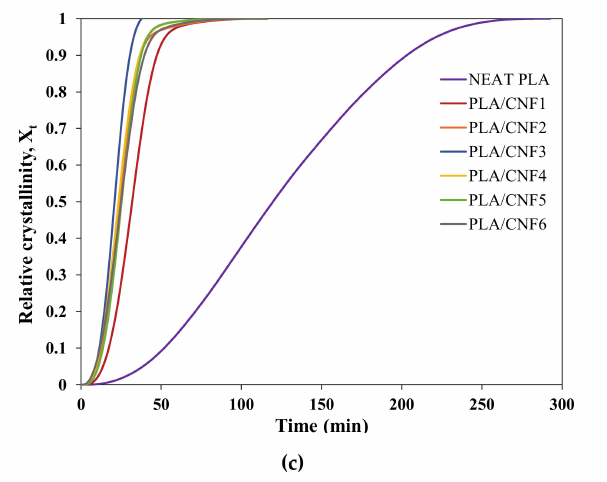
Figure 3. The relative crystallinity of neat PLA and PLA/CNF nanocomposites at ( a ) 90, ( b ) 100, and ( c ) 110 ◦ C.